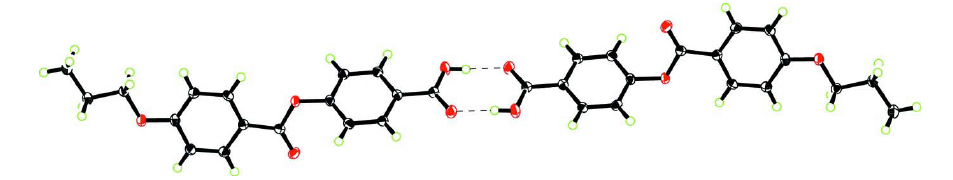
Figure 2 Showing hydrogen bonded molecules through